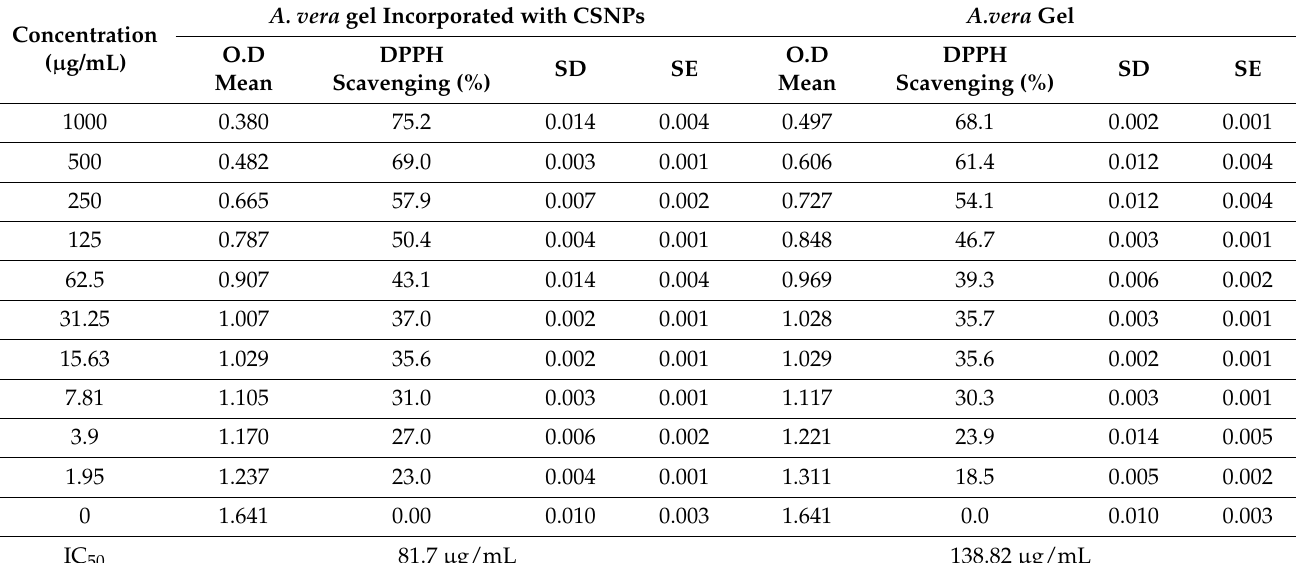
Table 4. Antioxidant activity of A. vera gel and A. vera gel incorporated with CSNPs.